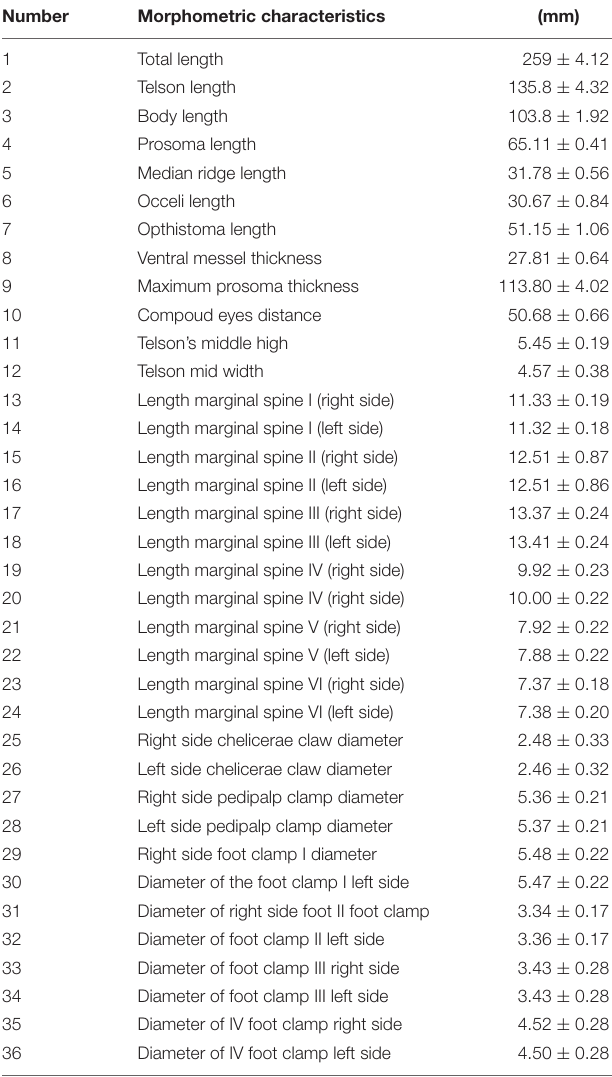
TABLE 1 | Morphometric measurements of mangrove horseshoe crab ( Carcinoscorpius rotundicauda